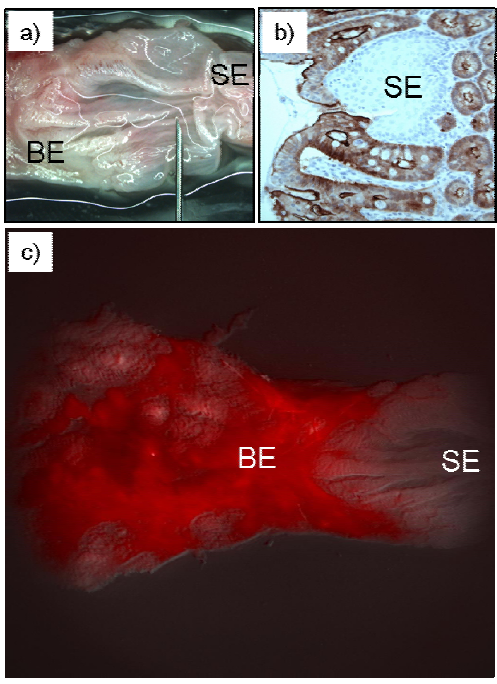
FIGURE 8. Example of in vivo targeted labeling of QDots in Barrett’s esophagus rat model. (a) White light image of resected rat esophagus, (b) ex vivo tissue section stained immunohistochemically for villin (brush-border protein) expression, and (c) fluorescence image of the luminal surface of the esophagus, with topical application of a conjugate comprising 660 nm–emitting QDots conjugated to an antibody targeted to the brush-border protein called villin that is overexpressed in Barrett’s esophagus tissue (BE = Barrett’s mucosa, SE = squamous esophageal